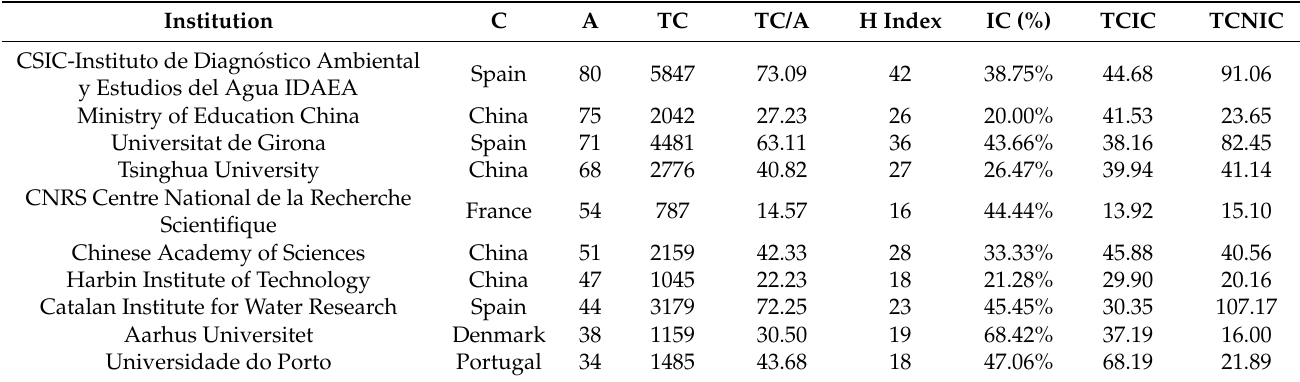
Table 6. Characteristics of the most outstanding institutions.